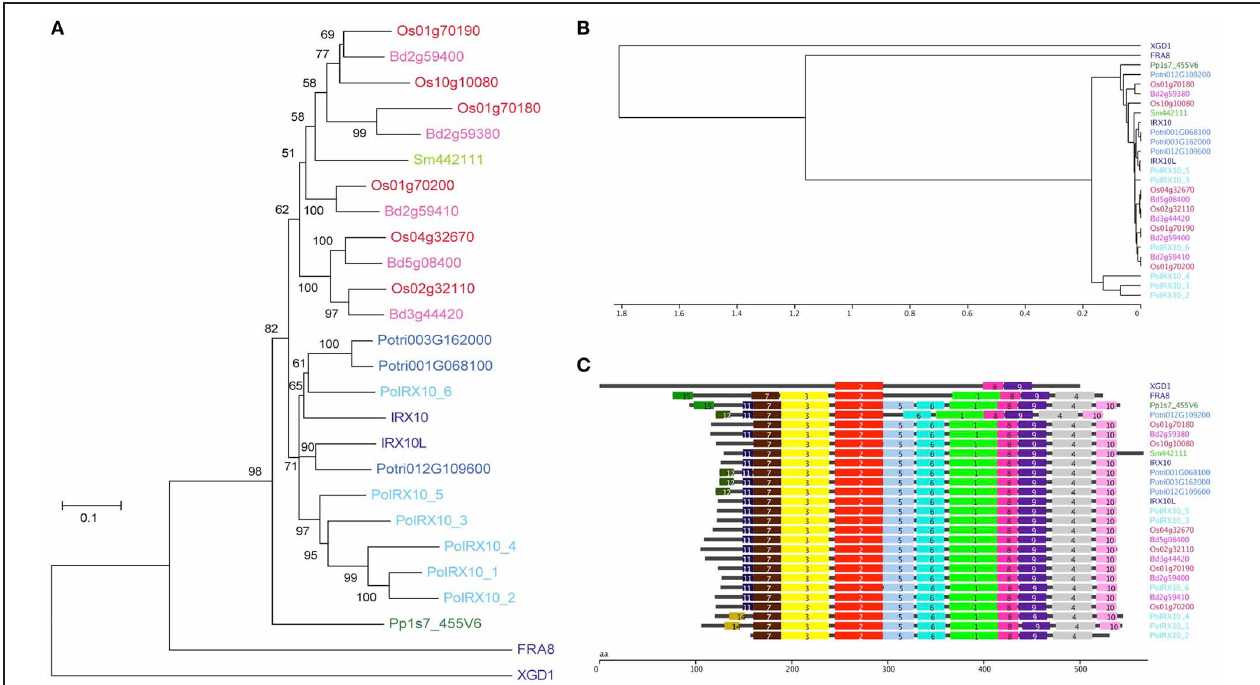
FIGURE 3 | Phylogenetic and motif analysis of IRX10 homologs in psyllium. (A) Phylogenetic analysis of IRX10 homologs in psyllium (light blue) and six other plants; Brachypodium distachyon (pink), rice (red), Arabidopsis (dark blue), poplar (blue), Selaginella moellendorffii (light green) and Physcomitrella patens (green).